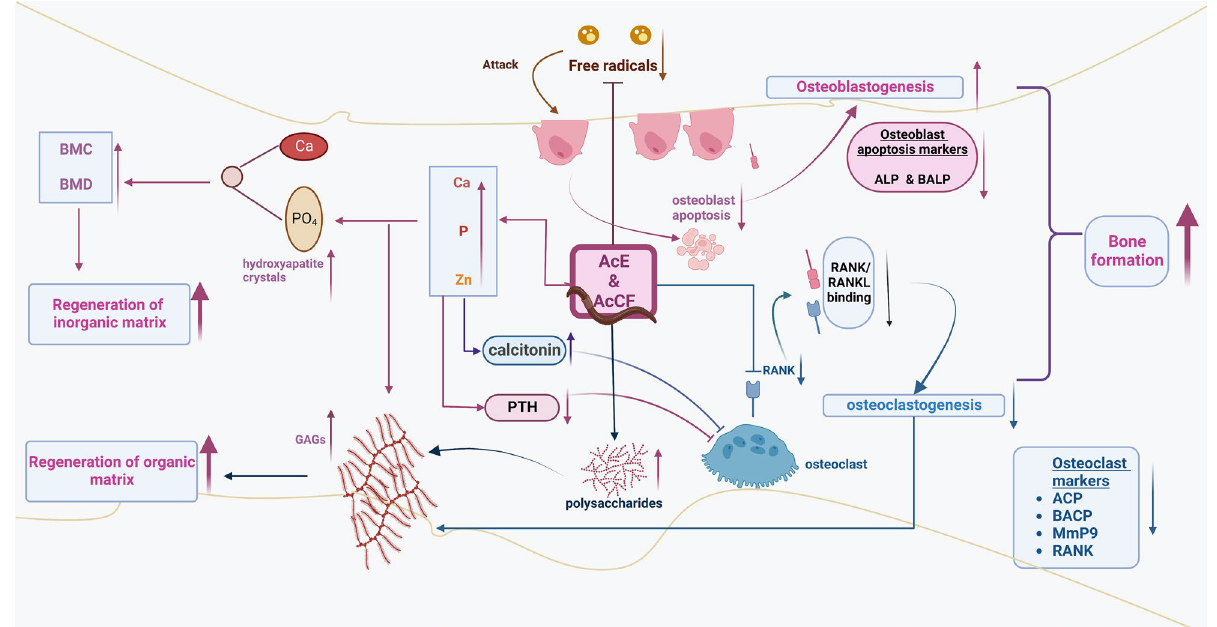
Figure 6. Schematic diagram showing the chemo-preventive potency of AcCF and AcE on bone compartments via multiple pathways against GIOP; (1) bone cells, (2) inorganic matrix, and 3) organic matrix. Through antioxidant effect, AcE and AcCF treatment inhibit osteoblast apoptosis. Osteoclastogenesis has been decreased by RANK downregulation, which causes the RANK/RANKL pathway to malfunction. Calcium, phosphorus, and zinc content in AcE and AcCF promote the renewal of the inorganic matrix by increasing BMD and BMC and aiding in hormone homeostasis (PTH and calcitonin). Calcium and zinc increased GAGs formation by forming chondroitin sulfate calcium complex. Polysaccharide content in AcE and AcCF has increased GAGs content, regenerating the organic bone